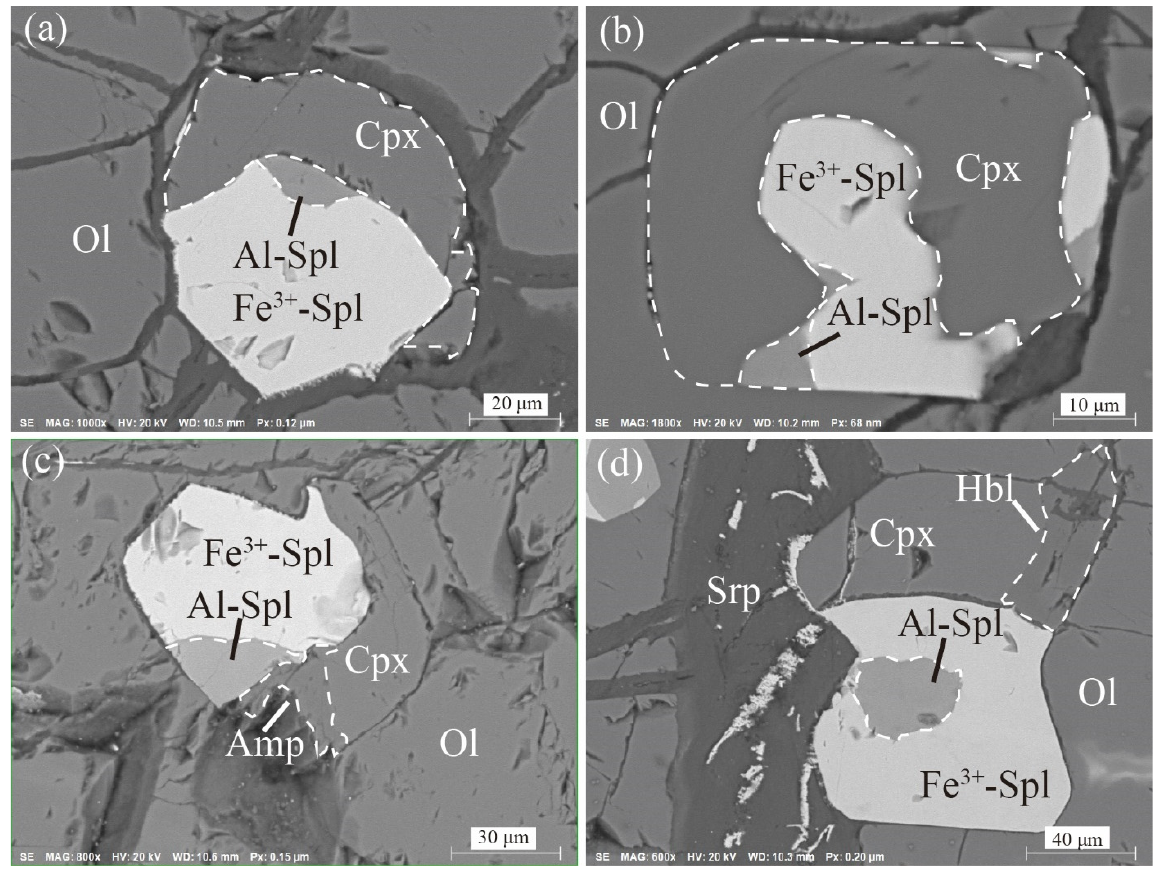
Figure 3. BSE images of dunite from the Duke Island complex. ( a – d ) Close up of multi-phase inclusions in olivine. Spl, spinel; Amp, amphibole.